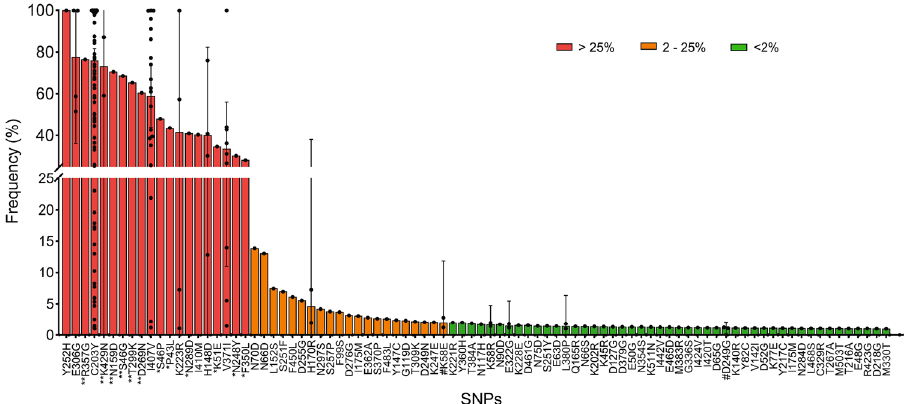
Figure 3. Frequency of PfRh5 SNPs in individual complex infections SNP frequency was determined from the sequencing read data and calculated as the percentage of the variant read coverage relative to the coverage at the variant position. Using quantitative read coverage, we are able to calculate frequency within the overall Plasmodium genetic material in a given sample, incorporating multiple genotypes as well as variable parasitemia across genotypes. SNPs are categorized as low < 2% (green), intermediate 2–25% (orange) or high frequency SNPs > 25% (red), based on their respective frequency with the sample population. Additional symbols are used to highlight SNPs occurring at high prevalence but low frequency (“#”), SNPs occurring at low prevalence relatively high (*) or very high frequency (**).